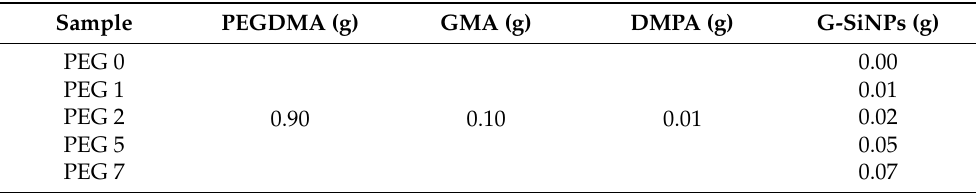
Table 1. Formulation of ultraviolet (UV)-curable PEG-GMA hydrogel mixtures containing synthe- sized